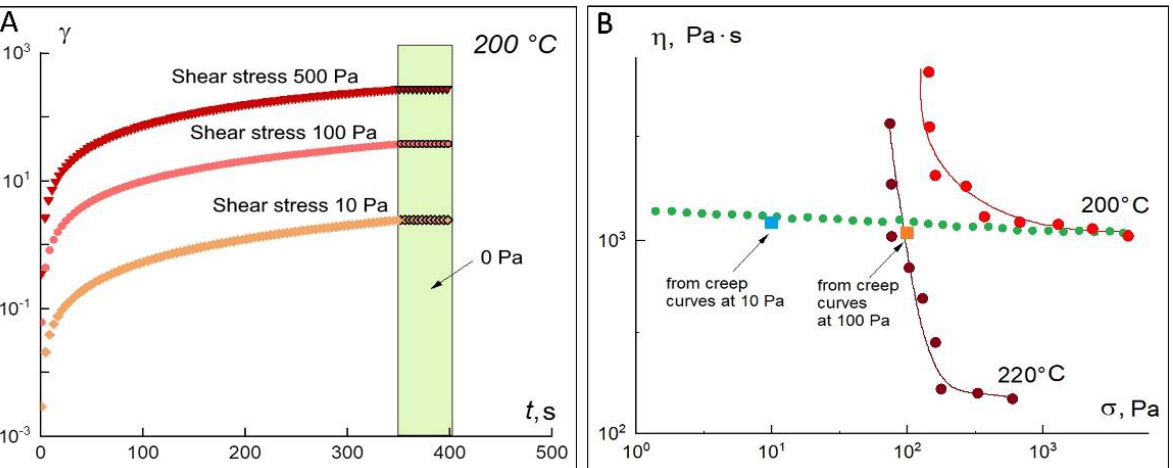
Figure 6. Shear stress-time dependence of polylactide at constant stress in “ loading-unloading ” mode at 200 °C ( A ). Viscosity versus shear stress for PLA at different temperatures, as well as vis- cosity values calculated from creep curves at different loads ( B ).